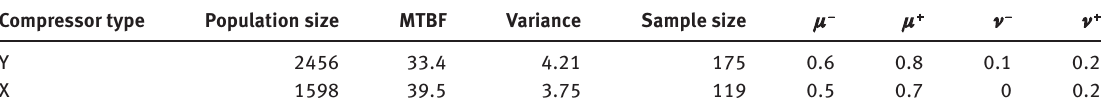
Table 2: IVIF Data Regarding Two Types of Radiators (Finite Populations).